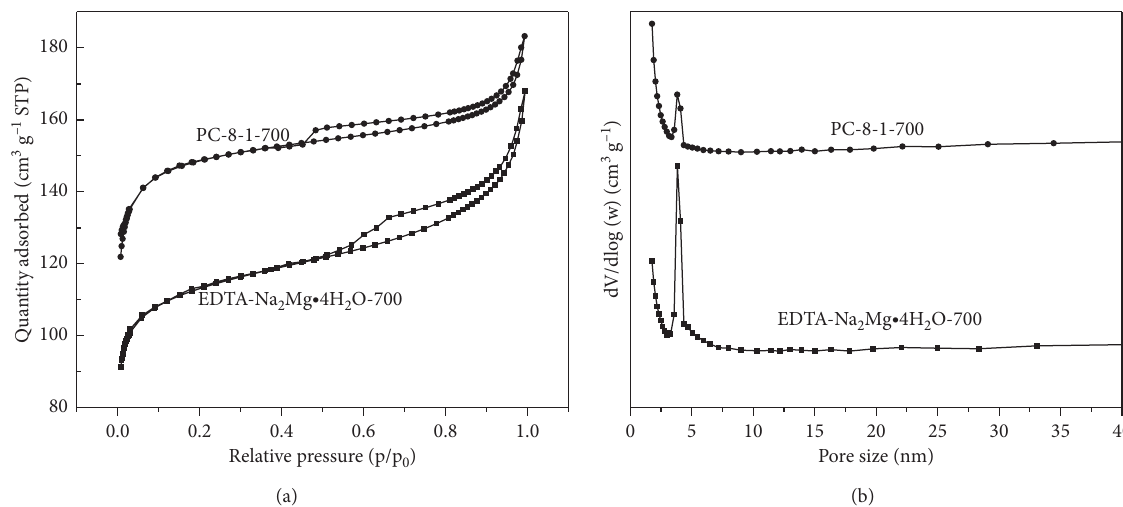
Figure 7: The N 2 adsorption-desorption isotherm and the BJH pore size distribution of PC-8-1-700 and EDTA-Na 2 Mg Table 2: Pore structure parameters of PC-8-1-700 and EDTA-Na